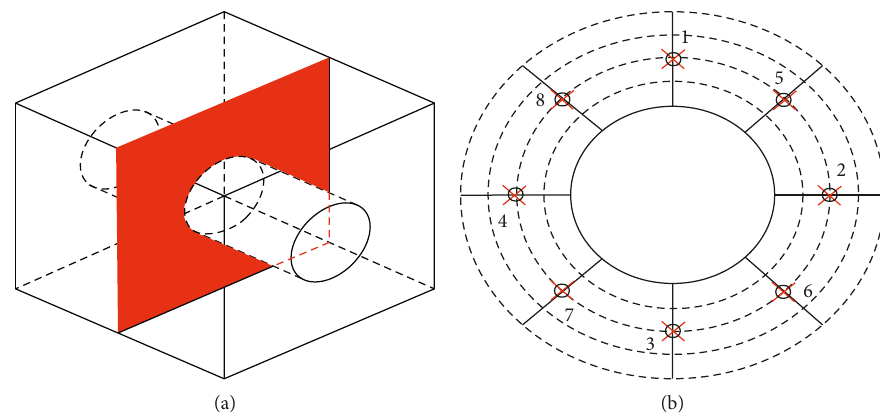
Figure 3: FBG sensor layout diagram: (a) grating sensor layout plane and (b) location of measuring points.